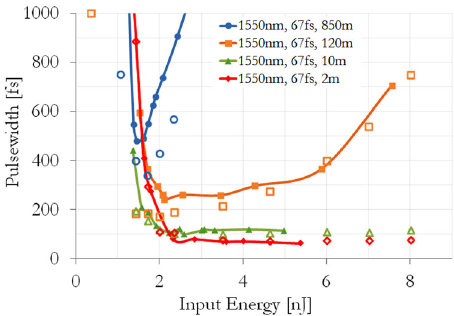
Fig. 4 Measured soliton pulsewidth vs. input energy, for input pulses with 1550 nm wavelength, 67 fs pulsewidth, and 15 µ m input waist, respectively, with graded-index (GRIN) fi ber spans of length 2, 10, 120, and 850 m. Measurement error comes directly from the instrument accuracy, that is below 1%, too small to be visible at this